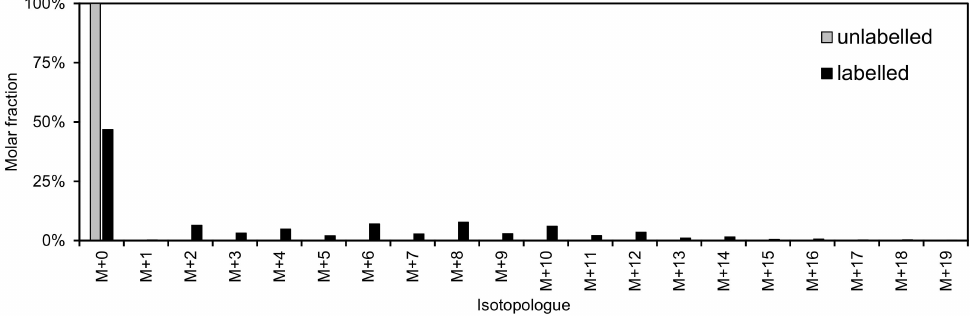
Figure 4. 13 C labelling of PC 34:1 from A549 cells grown on monoisotopic and 13 C-labelled glucose (data from Figure 2). Isotope correction was performed using IsoCor